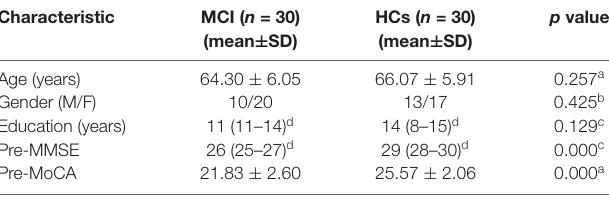
TABLE 1 | Demographic data and cognitive scores in MCI patients and HCs.